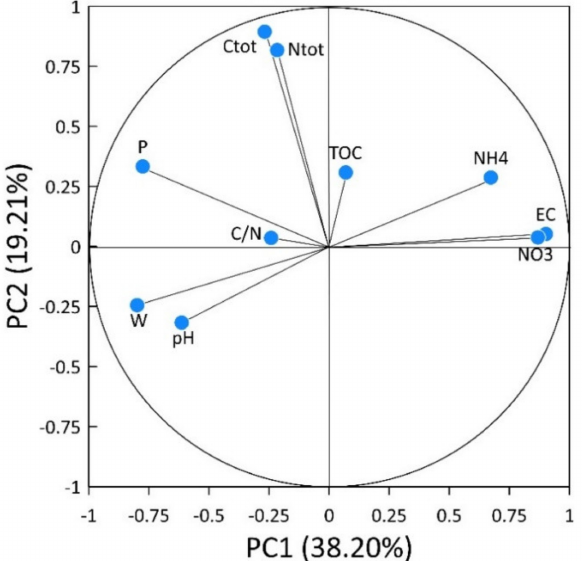
Figure 1. Principal component plot for the chemical soil properties at the end of cauliflower growing.